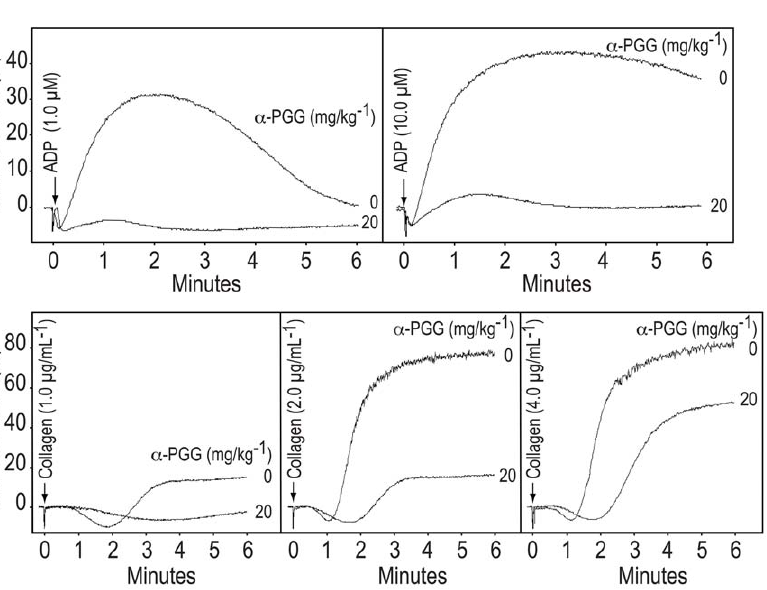
Figure 6. Administration of a -PGG inhibited exvivo platelet aggregation induced by ADP or collagen. A, ADP or B, collagen was added to platelet-rich plasma, prepared from murine blood drawn at 30 min after oral administration of a -PGG (20 mg kg 2 1 ) or vehicle, to induce aggregation. The aggregation tracings are representative of three experiments.